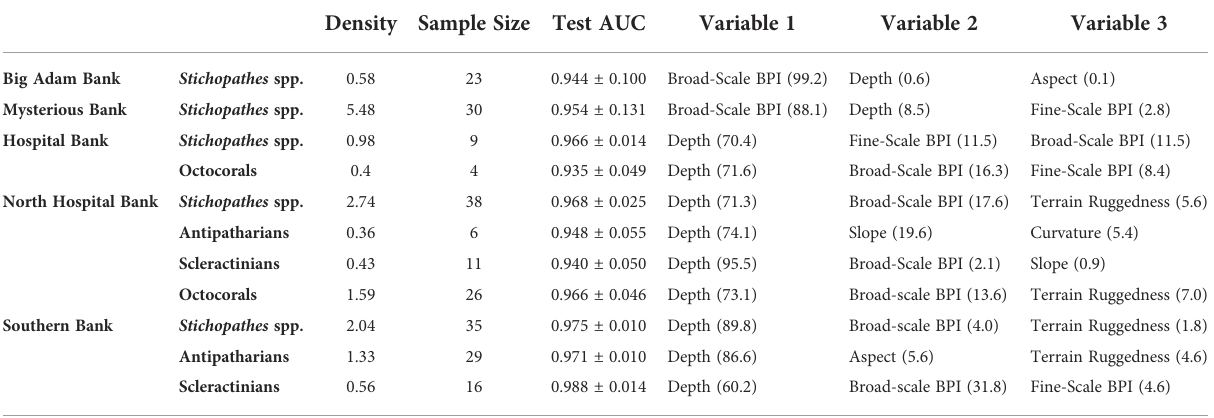
TABLE 3 MaxEnt data with parameters and variables with most importance on coral habitat suitability